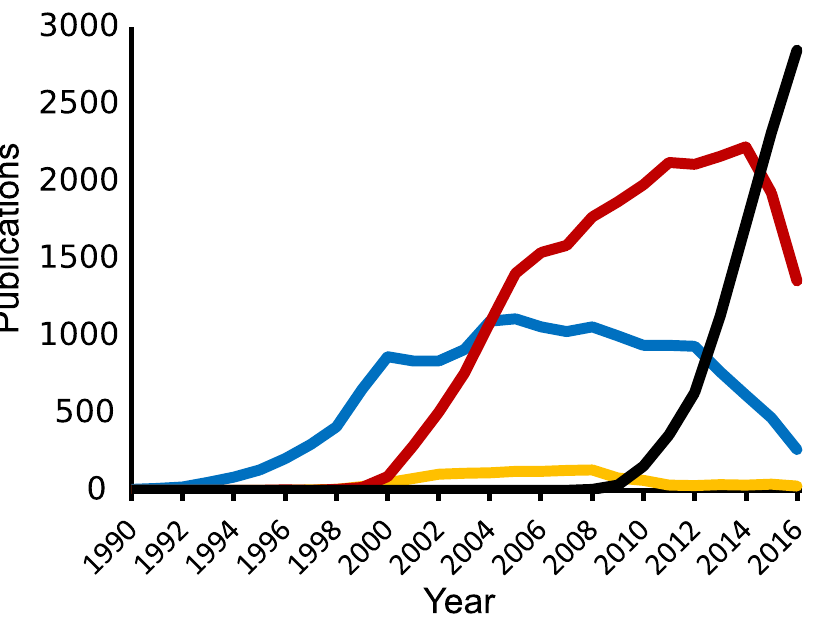
Fig 1. Transcriptomics method use over time. Publishedpapers since 1990, referringto RNA sequencing (black), RNA microarray(red), expressedsequencetag (blue), and serial/capanalysisof gene expression (yellow)[12].